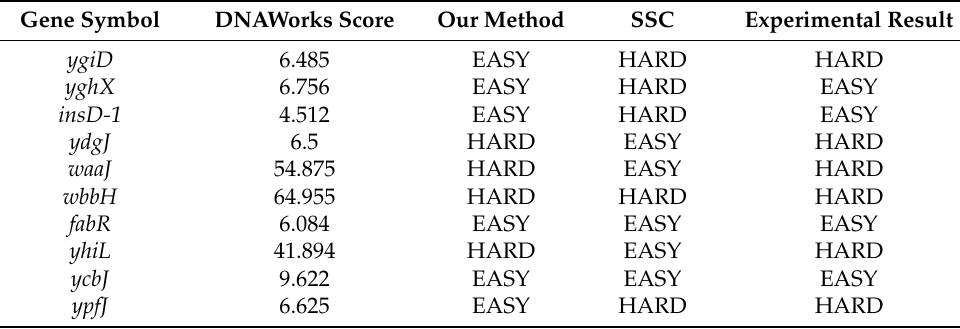
Table 1. Comparison of our methods with SSC based on 10 genes in E. coli